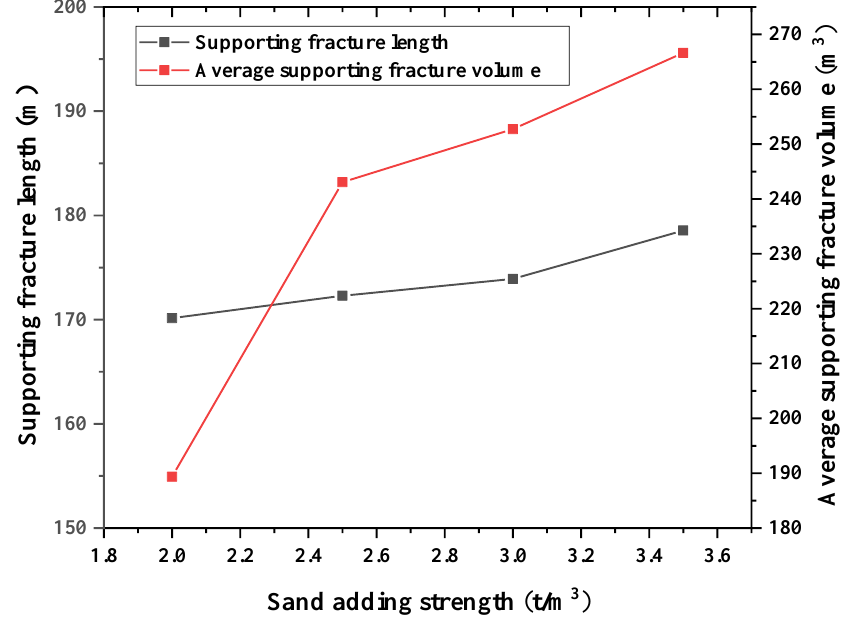
Figure 10. The change in supporting fracture length and volume under the different proppant mass.